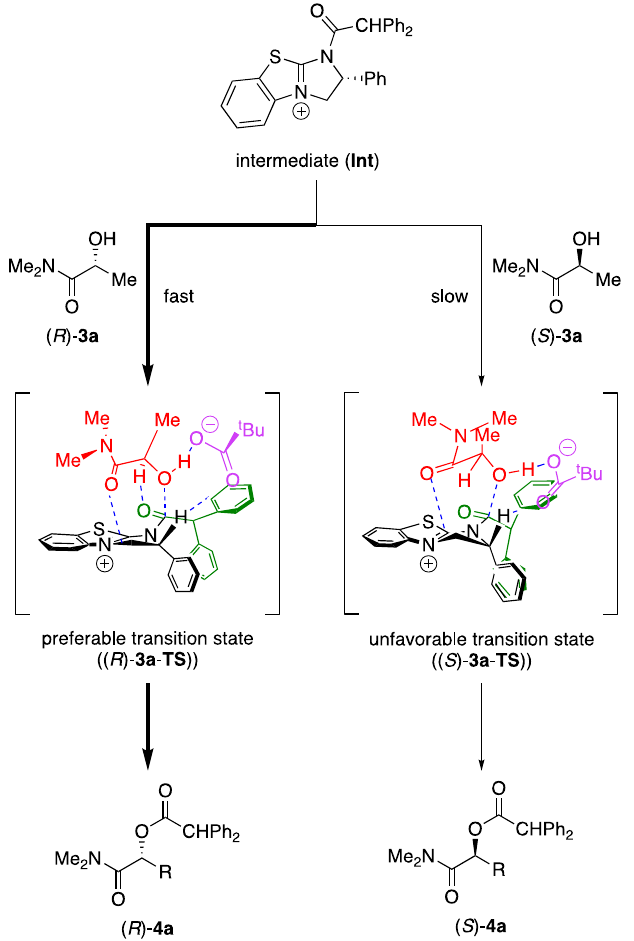
Scheme 2. Calculated transition states with a kinetic resolution (KR) of ( ± )- 3